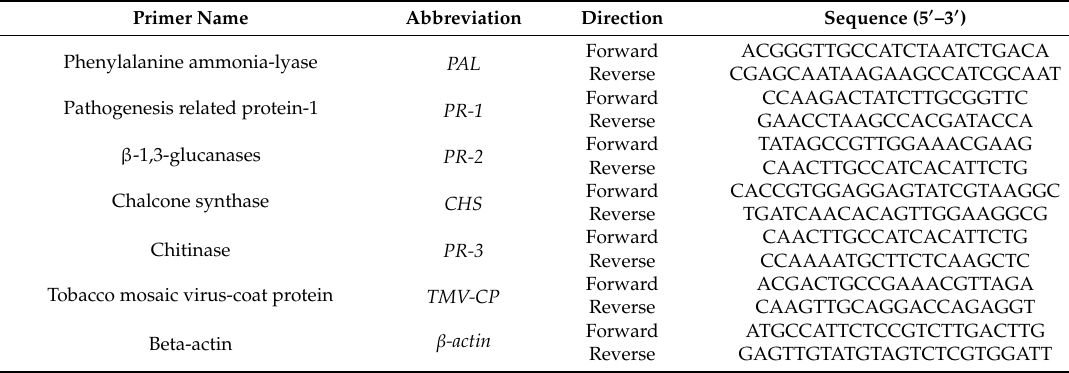
Table 2. Nucleotide sequences of qRT-PCR primers used in this